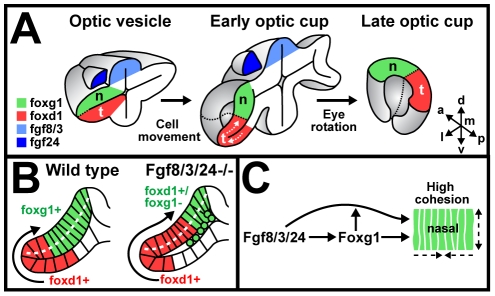
Model for retinal patterning and morphogenesis along the nasal-temporal axis.(A) Schematic cross-section, illustrating nasal-temporal pattern formation during optic vesicle and optic cup morphogenesis. Fgf8/3/24-dependent axis specification occurs along the dorsal-ventral axis of the optic vesicle (left). Initially, only nasal retina progenitors (green) populate the future neural retina domain. During optic cup formation, temporal progenitor cell movements (red) lead to axis reorientation (middle). In parallel, the eye rotates anteriorly. Together, these movements result in the anterior-posterior alignment of the nasal-temporal retina axis (right). (B) Directed, late movement of foxd1-expressing, temporal progenitors (red) around the distal ridge into the outer optic cup layer and gradual displacement of foxg1-expressing nasal progenitors (green) leads to the final nasal-temporal subdivision of the definitive neural retina domain in the outer optic cup layer (white dotted line). In the absence of Fgf8/3/24, misspecified (foxg1-negative/foxd1-positive) retinal progenitors in the presumptive nasal region (green) delaminate, and temporal progenitors (red) show increased cell movements into the outer optic cup layer. (C) Effect of Fgf signaling on cell cohesion and morphogenesis. Fgf8/3/24 are first required for foxg1 gene expression in nasal retina progenitors. Foxg1 protein enhances cell cohesion in the presence of Fgfs through an unknown feed-forward mechanism. The resulting retention of Foxg1-expressing cells at sites of Fgf signaling enhances the feed-forward effect. a, anterior; d, dorsal; l, lateral; m, medial; n, nasal; olf, olfactory placode; p, posterior; t, temporal; v, ventral.